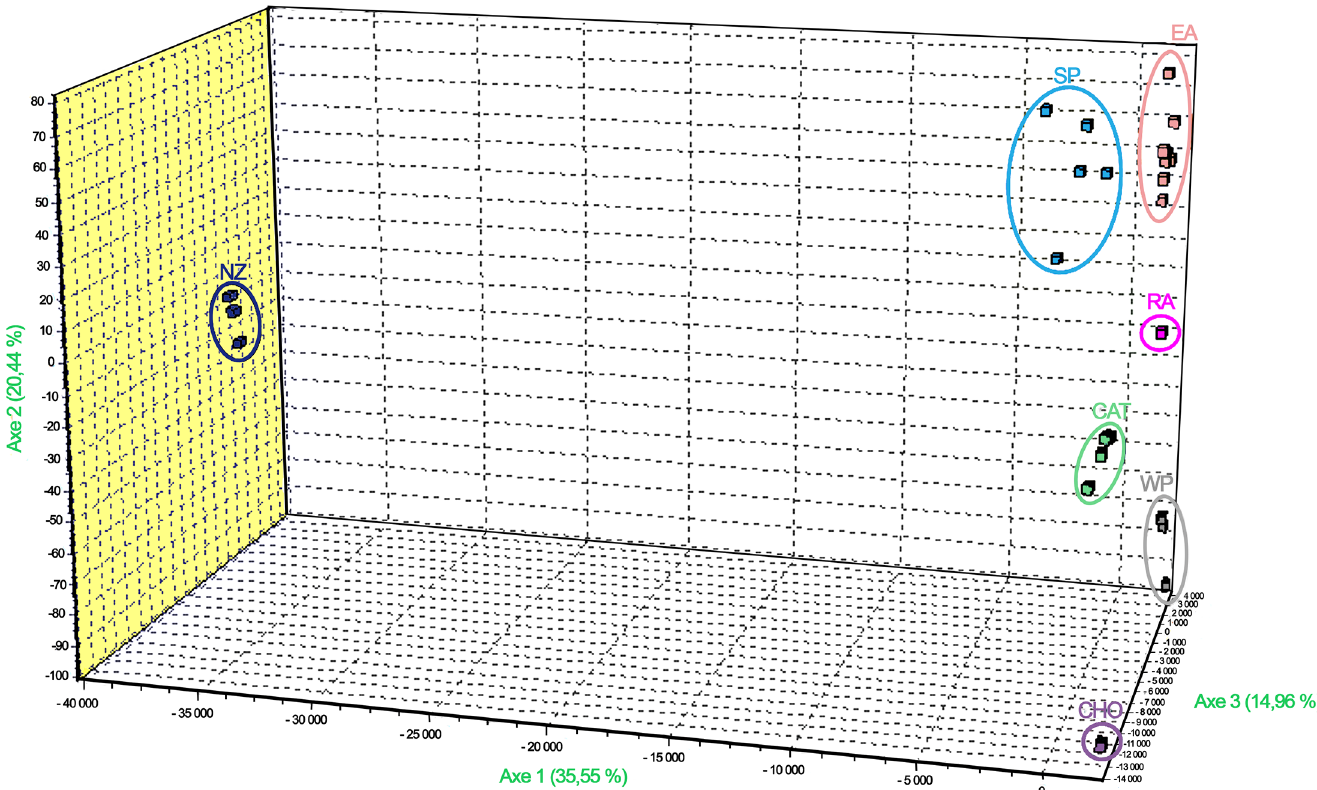
Fig 1. Factorial correspondence analysis (FCA) of Naegleria fowleri strains. The strains labelled in blue, orange, pink, green, grey, purple and black correspond to those that were assigned to the SP, EA, RA, CAT, WP, CHO and NZ respectively.